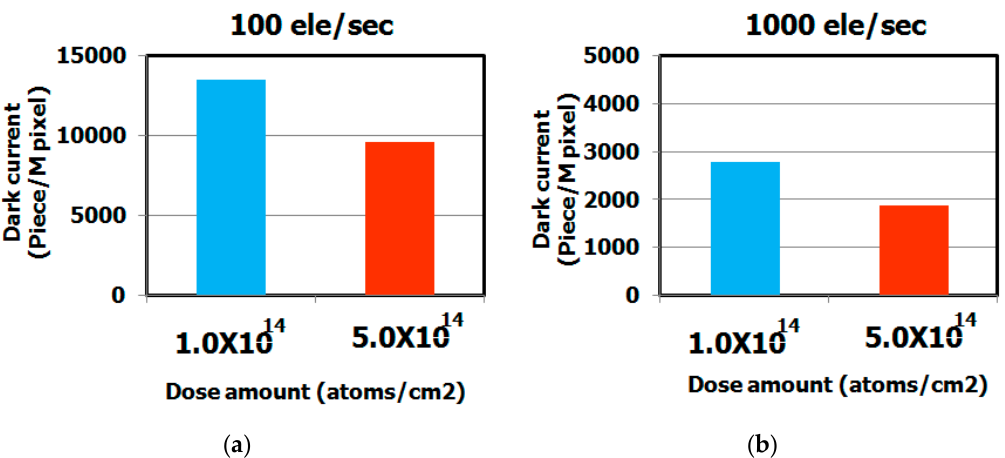
Figure 11. Histograms of dark current level of CMOS image sensor depending on hydrocarbon molecular-ion implantation dose after CMOS image sensor fabrication process. The epitaxial thickness is 5 μ m. The dark current levels were measured by dark current spectroscopy under 60 °C. ( a ) Number of middle range in white spot level depends on dose amount, ( b ) Number of large range in white spot level depends on dose amount.